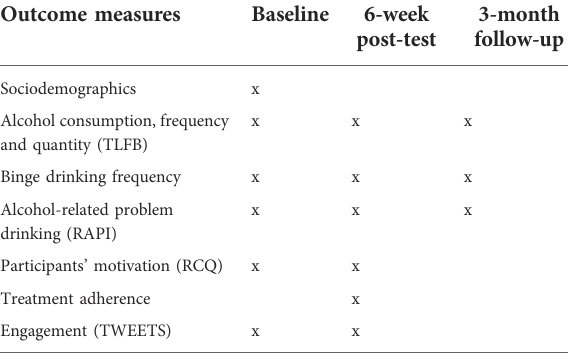
TABLE 1 Overview of measurements, timepoints and